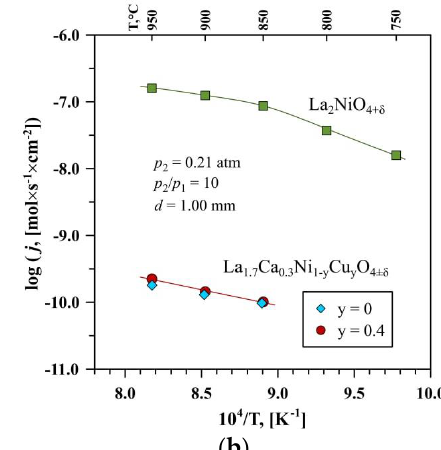
Figure 6. Temperature dependencies of the relative elongation of the La 1.7 Cа 0.3 Ni 1−y Cu y O 4+δ ceramic samples collected in a heating mode.